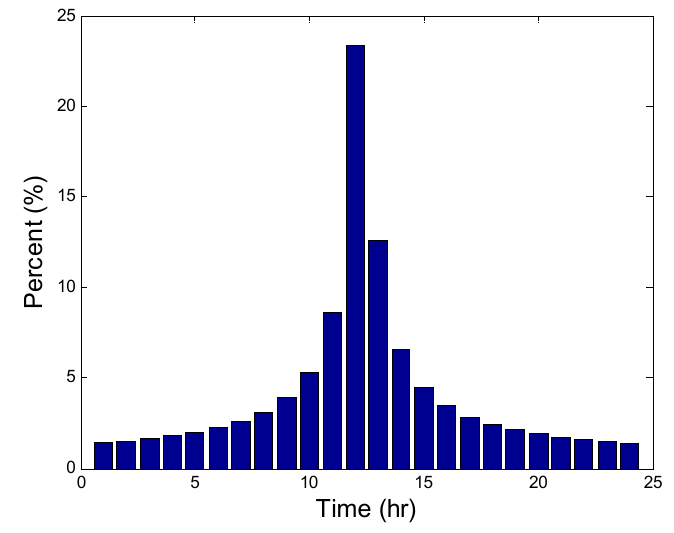
Figure 6. Horner hyetograph of 50-year recurrence interval in Liufenliao Station.